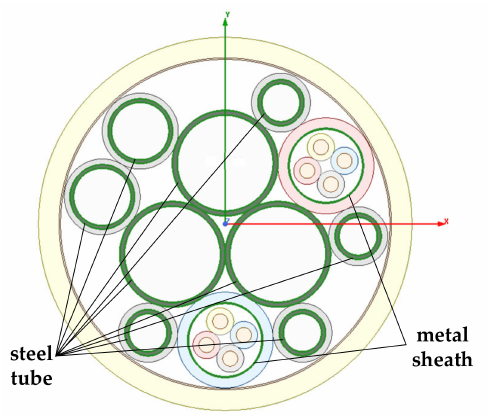
Figure 5. Schematic diagram of the cross section of the prototype umbilical cable.